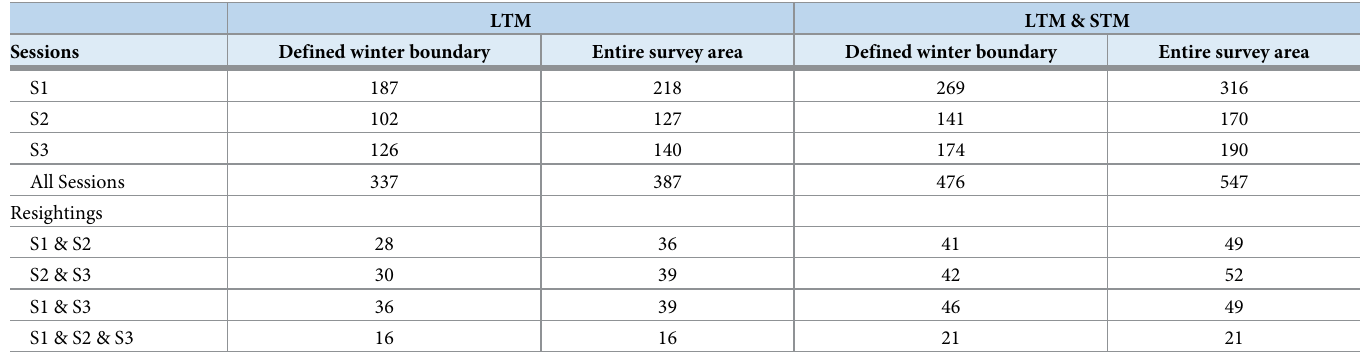
Table 7. Individually identified dolphins within and between sessions of a capture-mark-recapture survey of estuarine-resident bottlenose dolphins ( Tursiops trun- catus ) in southern North Carolina.